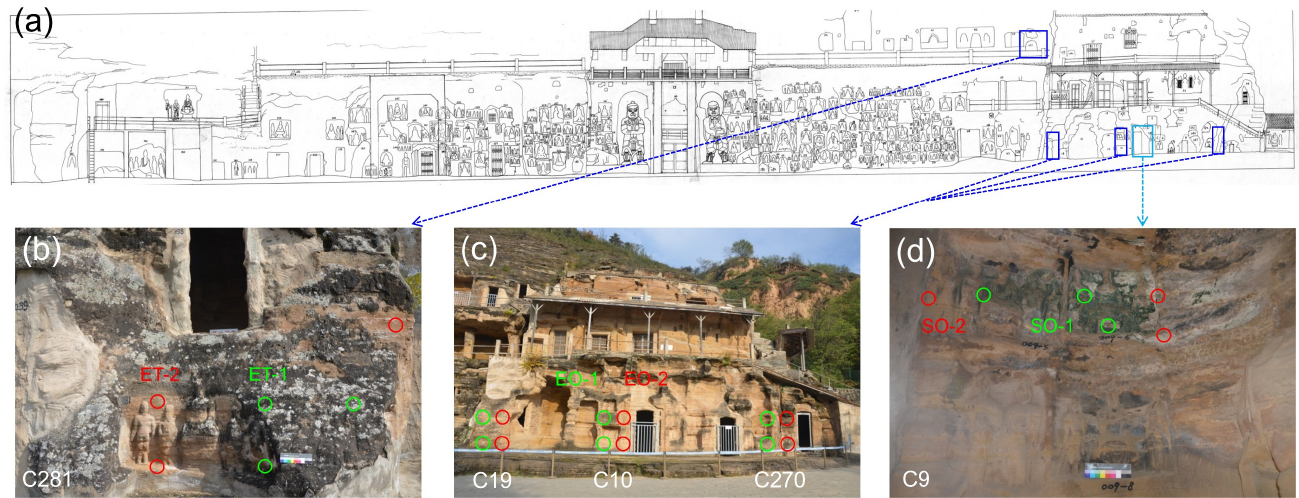
Figure 1. Relative positions of sampling sites at Beishiku Temple. Green circles refer to biofilm samples; red circles refer to weathered particulate samples. ( a ) is the sampling site and ( b – d ) are zoomed portions of subfigure ( a ) from where the samples were